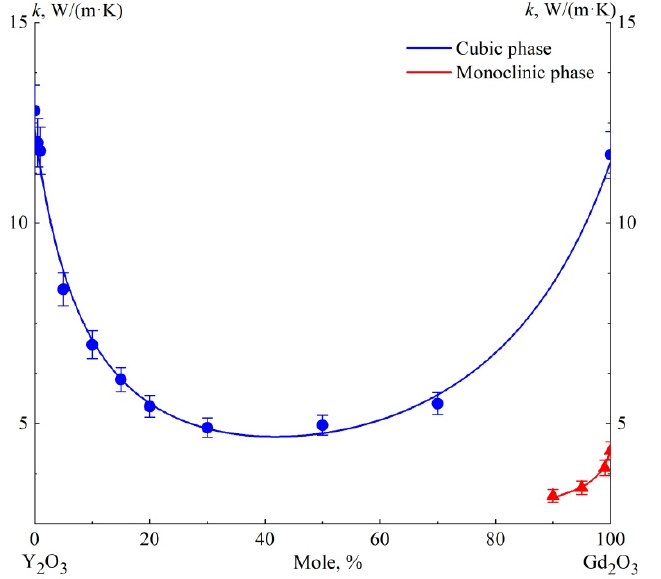
Figure 3. Dependence of thermal conductivity at 300 K of solid solution ceramics (Y 1 − x Gd x ) 2 O 3 on the composition.